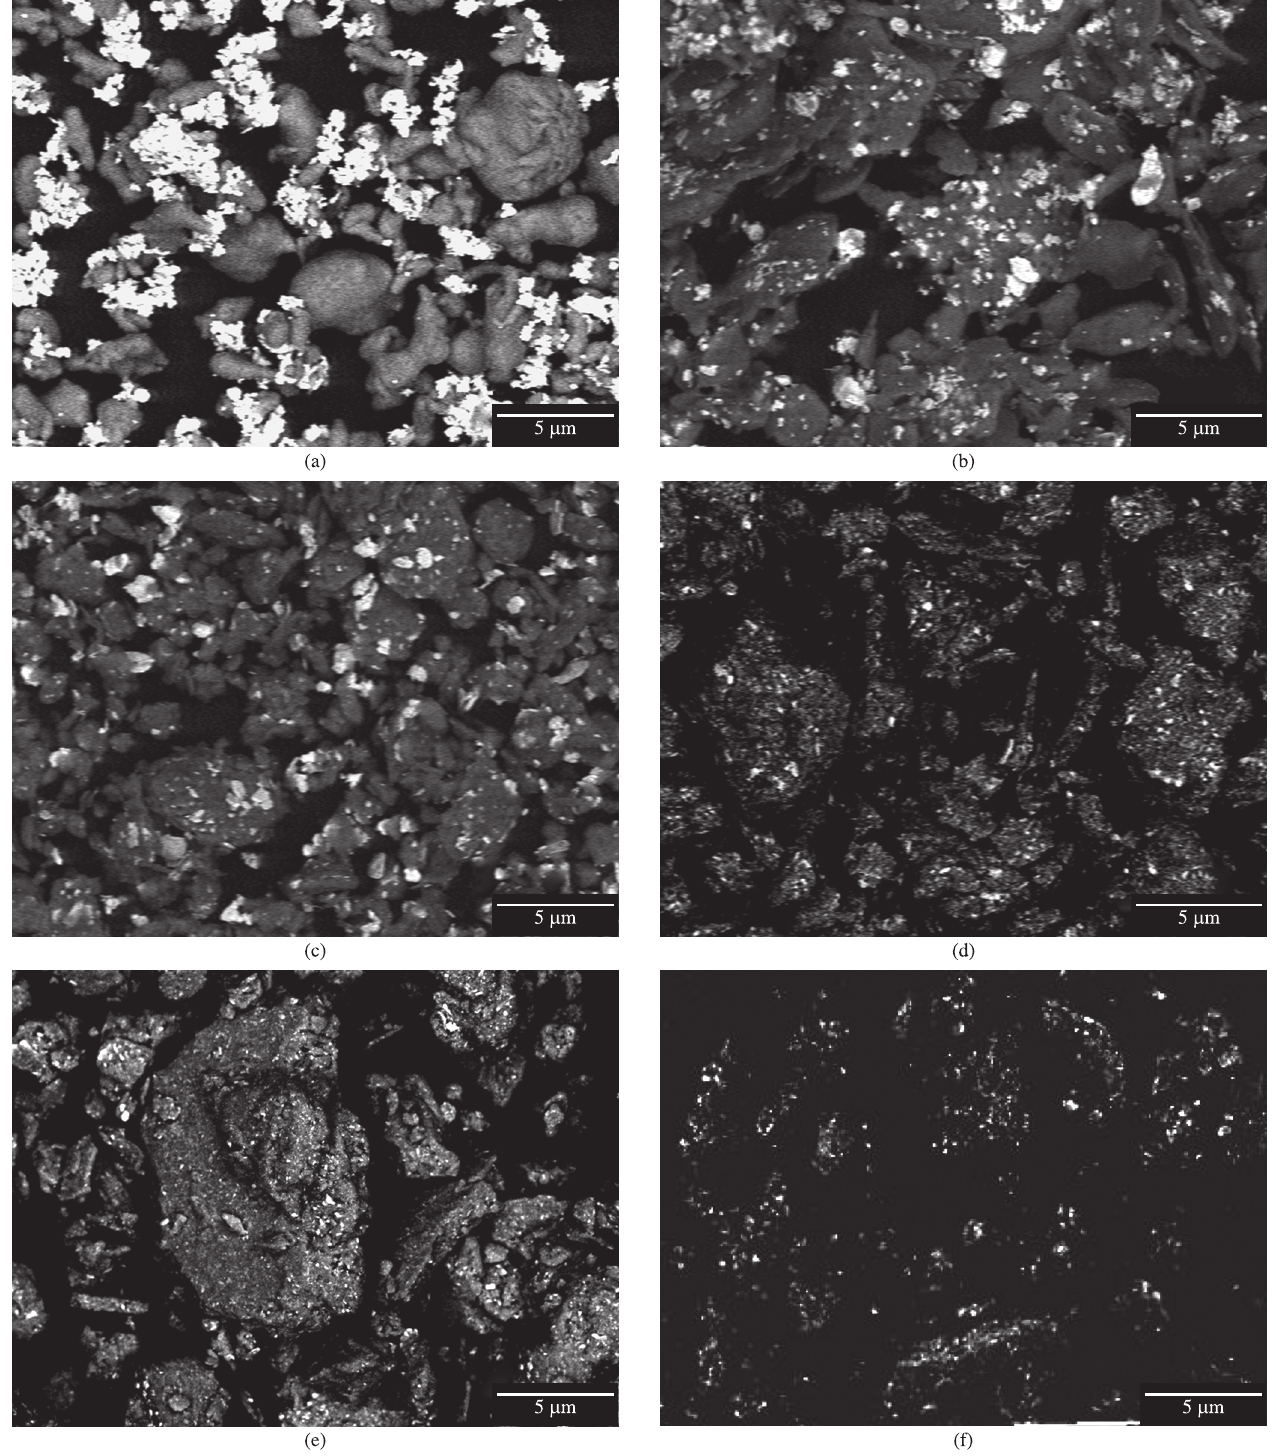
Figure 3. Morphology of Al-Mo powder mixture vs. milling time. Scanning electron micrographs, backscattered electron images. Milling time: (a) 0 hours, (b) 1 hour, (c) 10 hours, (d) 40 hours, (e) 70 hours, (f) 100